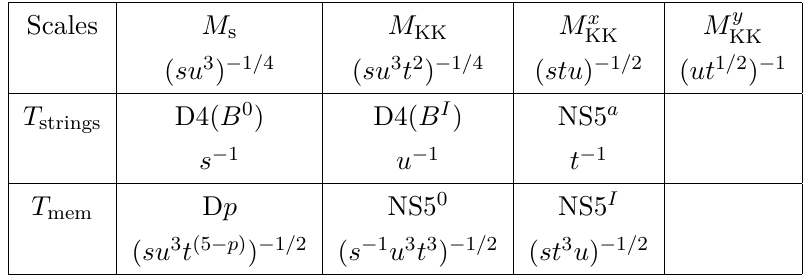
type IIA orbifold 2